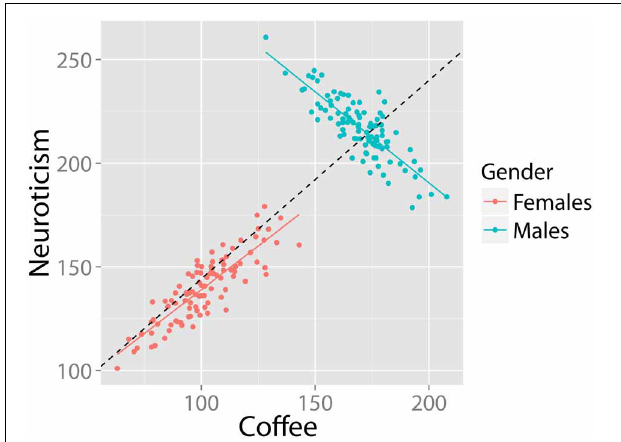
FIGURE 4 | Bivariate example where the relationship between coffee and neuroticism is positive in the population, despite being strongly negative in half the subjects. Data in arbitrary